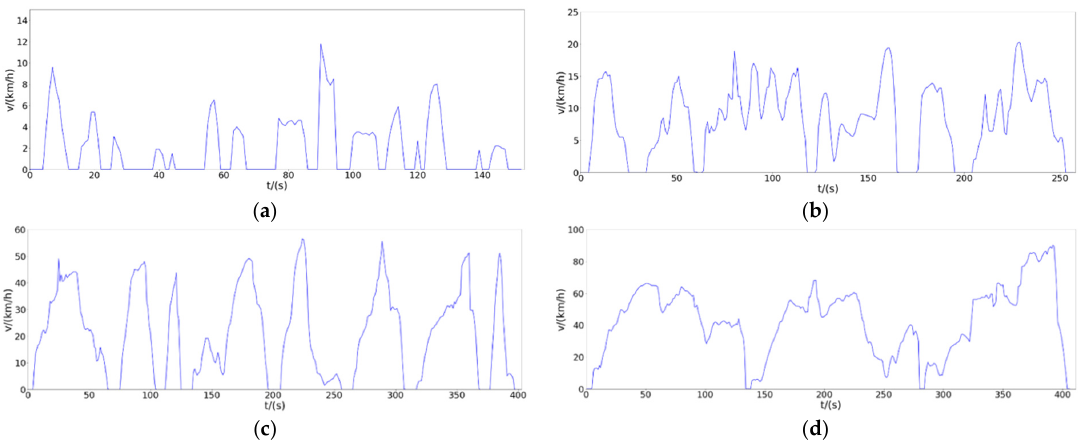
Figure 16. Driving cycle map detail display. ( a ) Low Speed; ( b ) Middle Speed; ( c ) High Speed; ( d ) Ultrahigh Speed.